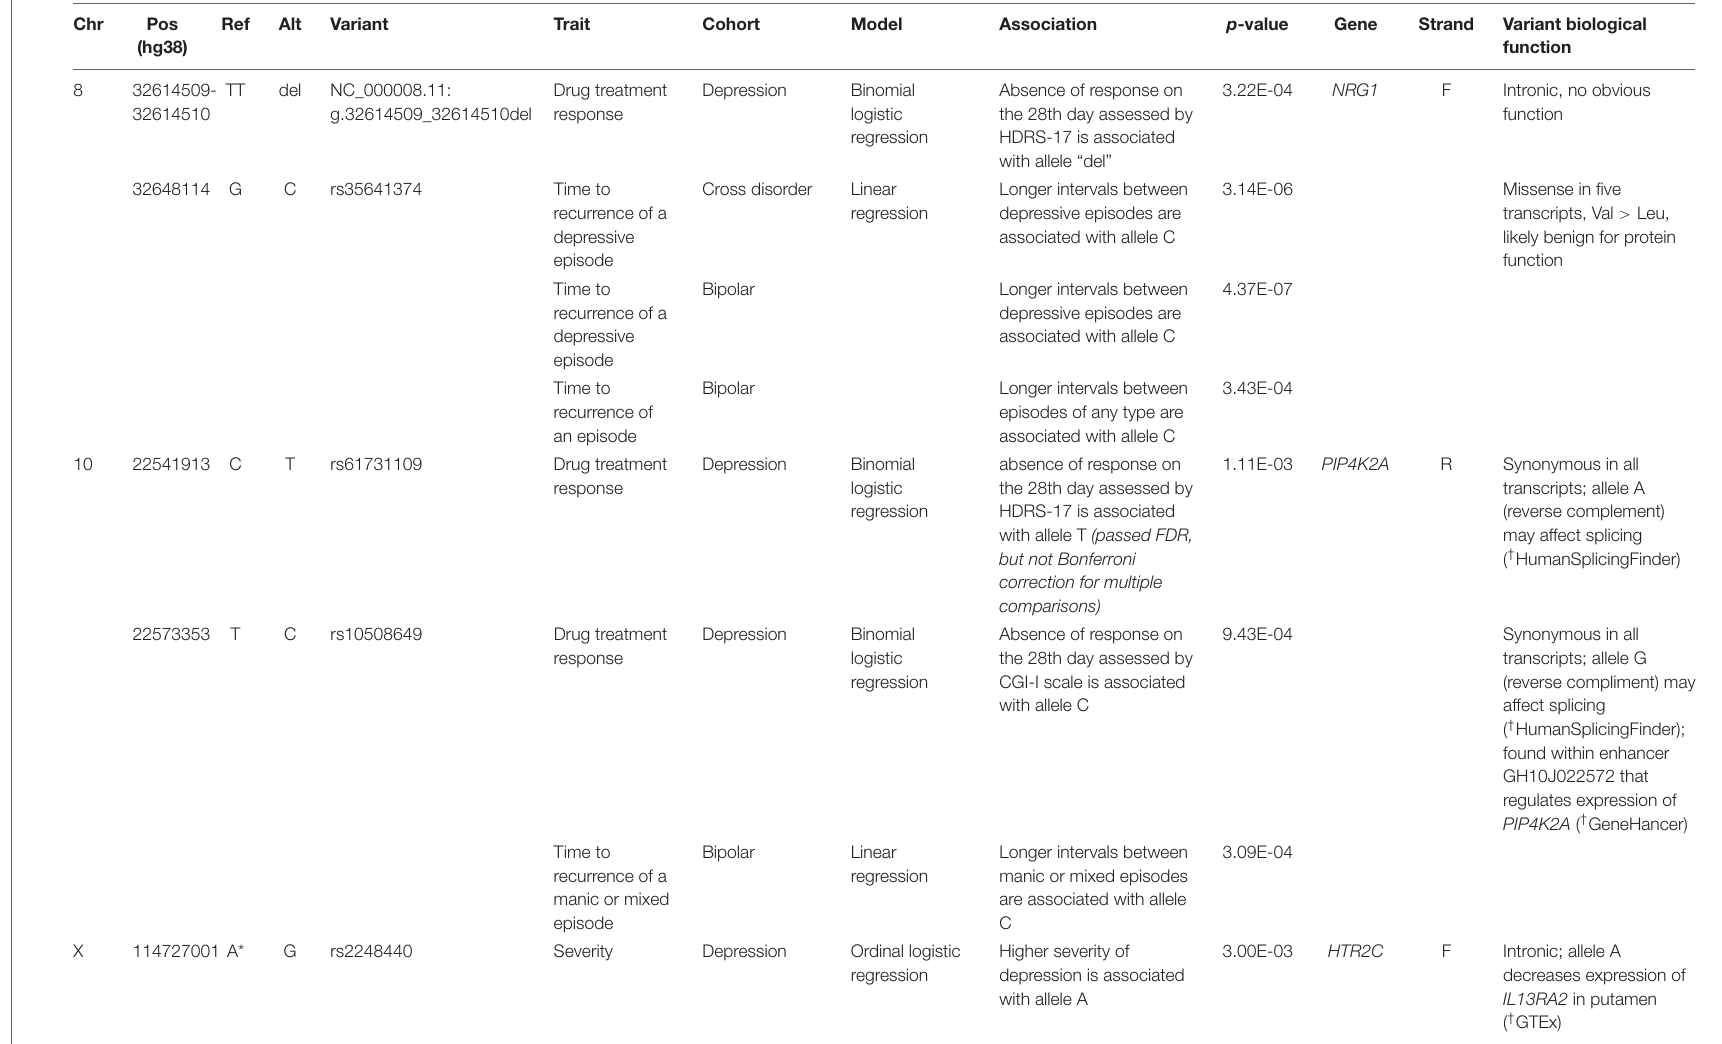
Chr, chromosome; pos, position in the human genome; ref, reference allele; alt, alternate allele; † used algorithms; * minor